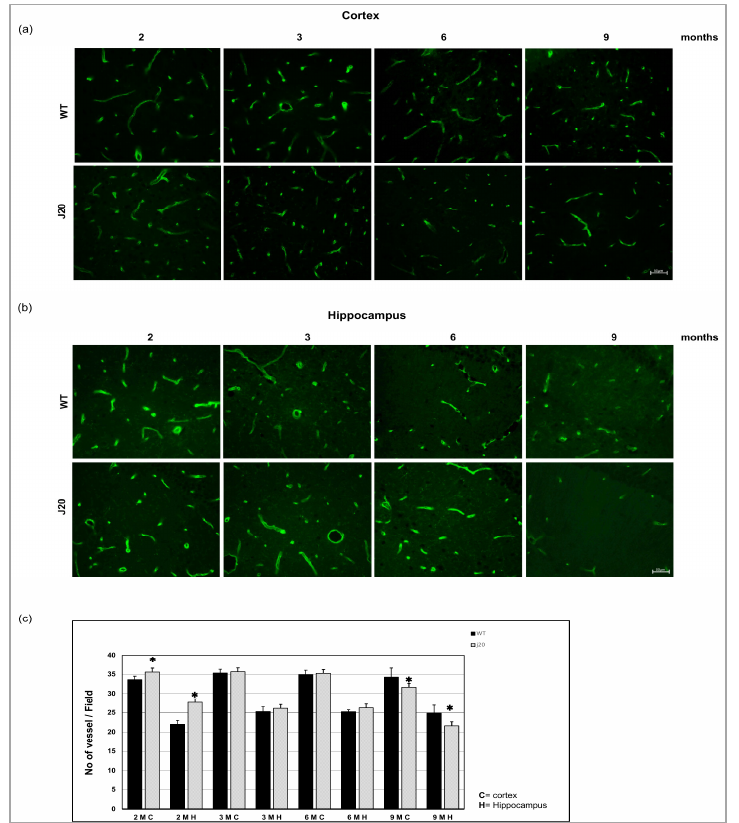
Figure 1. Immunofluorescence for the endothelial cell. Brain section was stained with FITC conju- gated solanum tuberosum in the cortex ( a ) and hippocampus ( b ) of WT and J20 mice brain at age 2, 3, 6, and 9 months of age. ( c ) The number of vessels per field at 400 magnifications in the cortex and the hippocampal area was counted in a blinded manner. Numerical data are presented here as av- erage ± SD, and statistical significance is denoted as * p < 0.05 vs. age-matched WT. M indicates month. Scale bar = 50 µm.